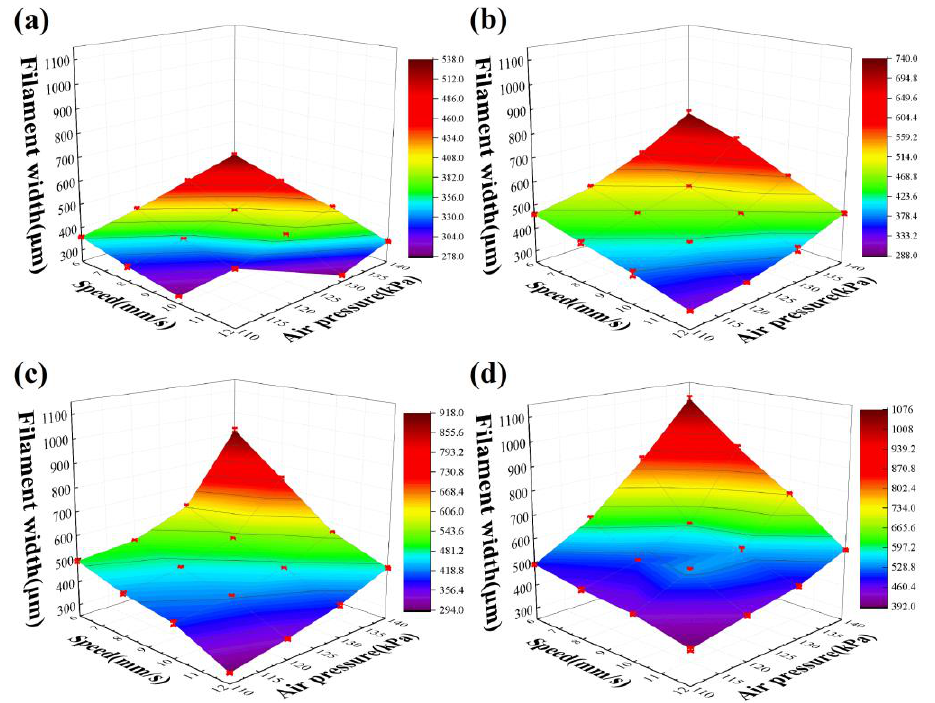
Figure 5. Heating-assisted direct writing parameters on: ( a ) room temperature substrate; ( b ) 90 °C substrate; ( c ) 120 °C substrate; ( d ) 150 °C substrate.